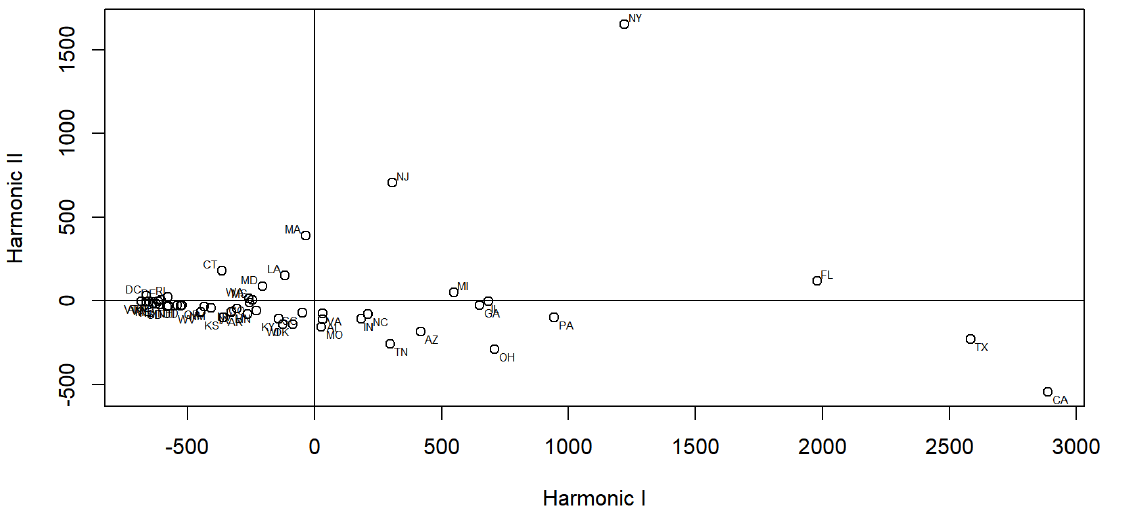
Figure 3. 2D Plot of FPCA for Daily COVID-19 Mortality Data.